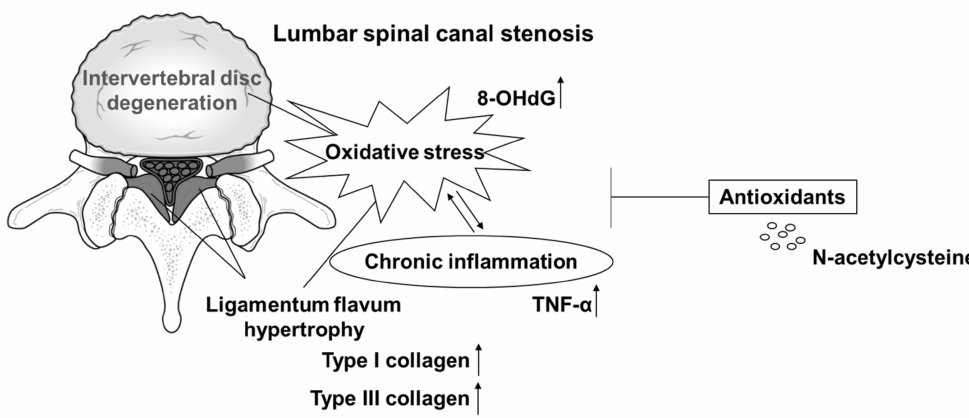
Figure 6. Schematic model showing the potential of N-acetylcysteine (NAC) as a preventive or therapeutic agent for lumbar spinal canal